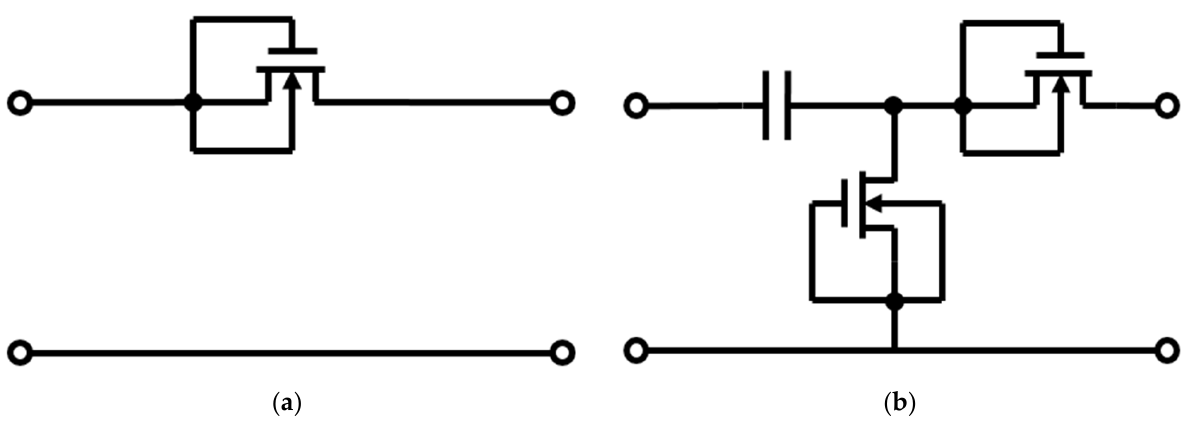
Figure 10. Rectifier candidates: ( a ) single diode rectifier (SD) and ( b ) voltage doubler (VD).